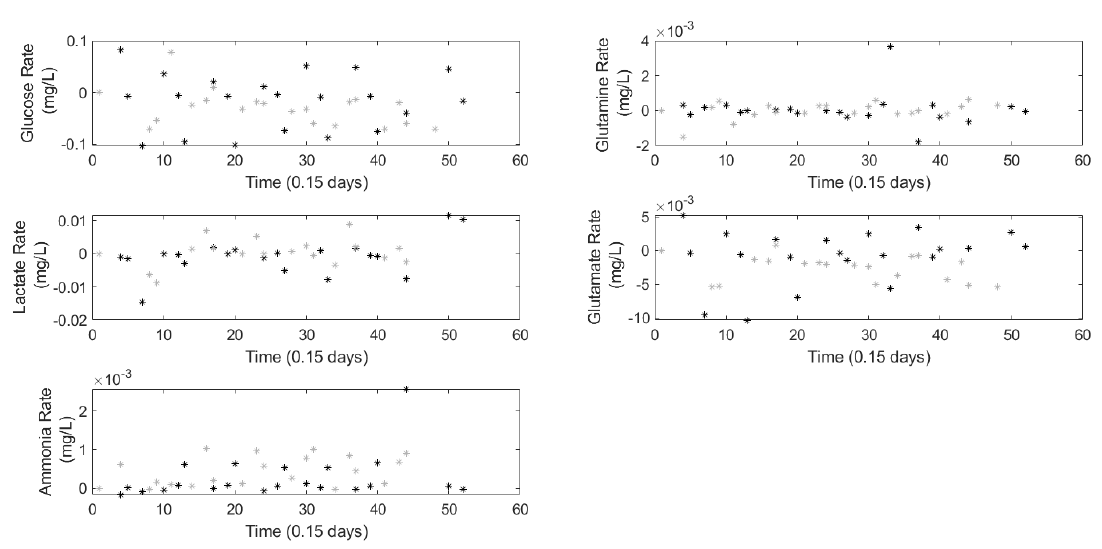
Figure 6. The output predictions (grey) from the metabolite model for each output are compared against the process data (black) for one training batch.